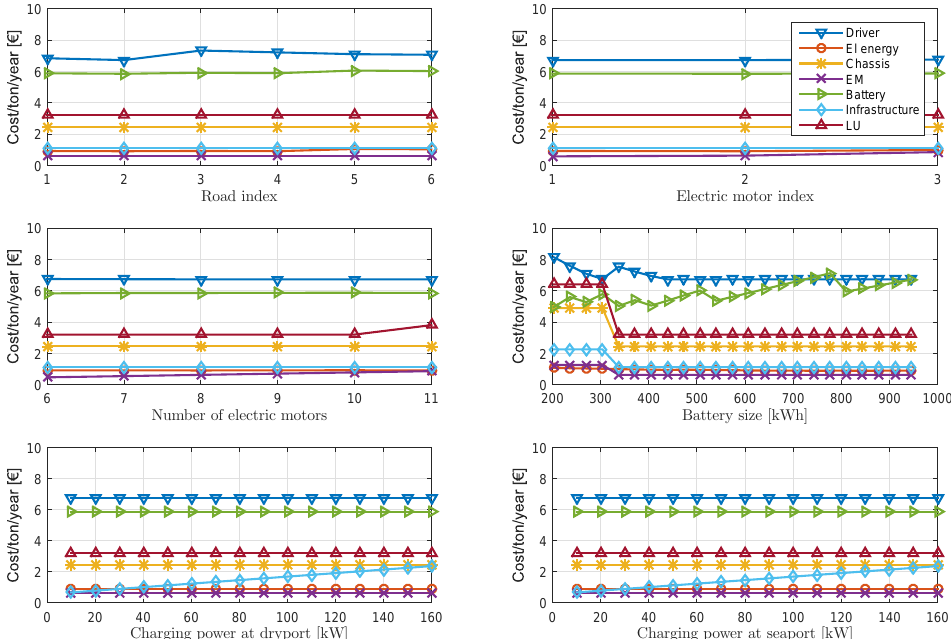
Figure 15. Sensitivity of annual costs incurred per unit freight with regard to different vehicles and transportation-design parameters for different cost indicators on first mission, X 1 r .